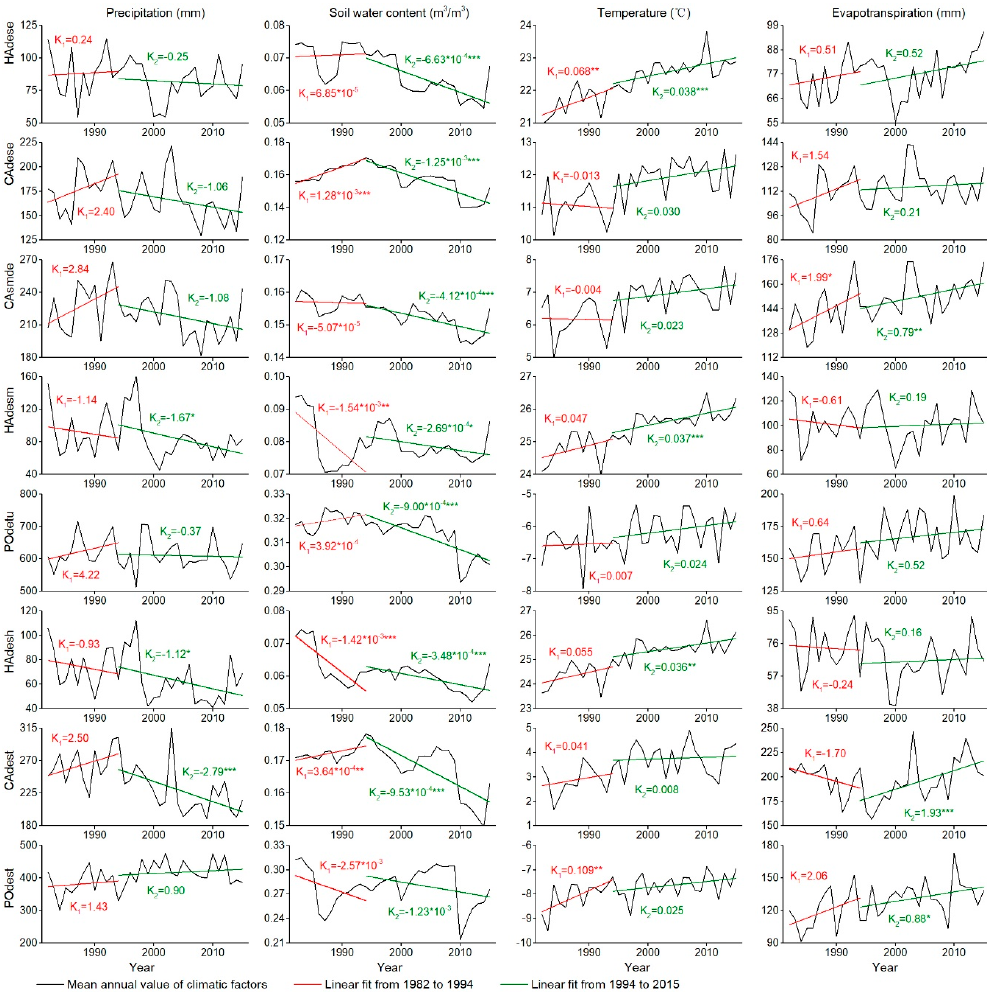
Figure 4. Interannual change of the mean annual value of climatic factors in different desert areas over the Silk Road Economic Belt from 1982 to 2015. K 1 and K 2 are the slope of the linear regression from 1982 to 1994 and from 1994 to 2015, respectively. *, ** and *** indicate statistical significance at p < 0.1, p < 0.05, and p < 0.01, respectively. HAdese—hot arid desert, CAdese—cold arid desert,